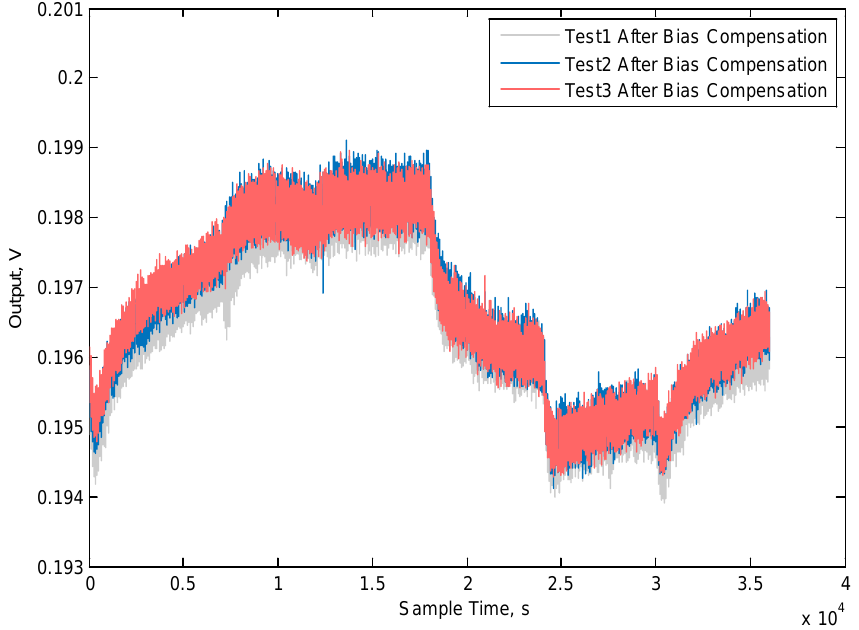
Figure 11. MEMS gyroscope temperature bias compensation results.